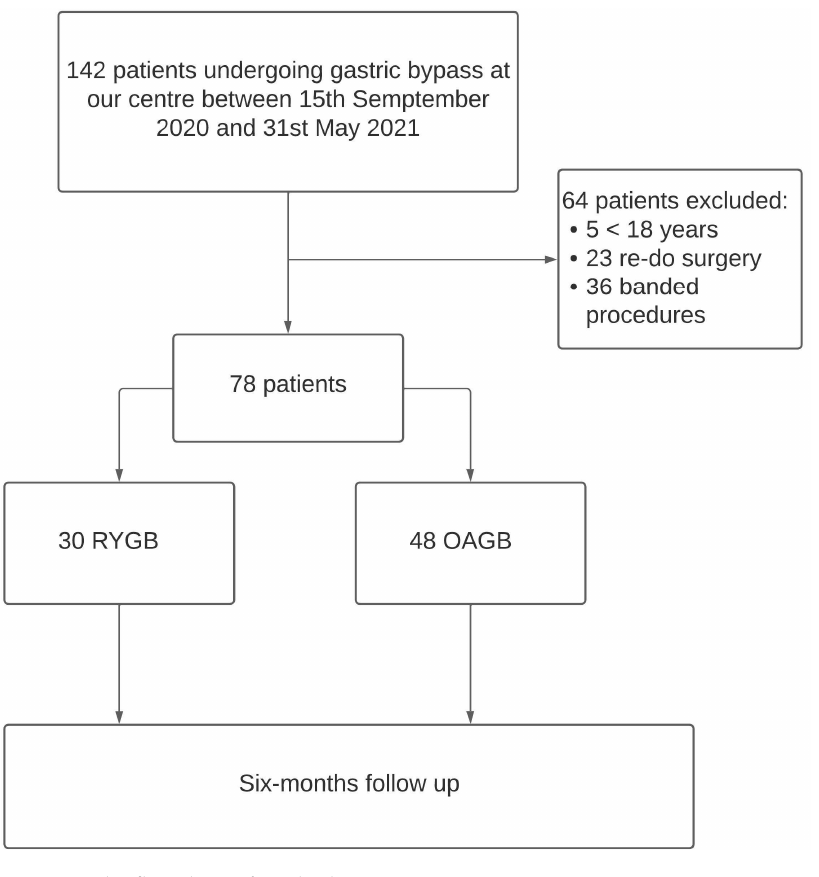
Figure 1. The flowchart of study design.